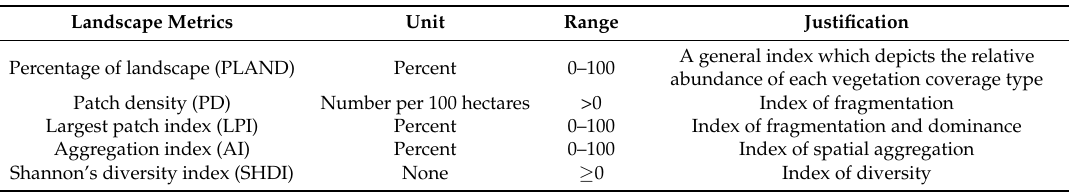
Table 1. Descriptions of landscape metrics used in this study.